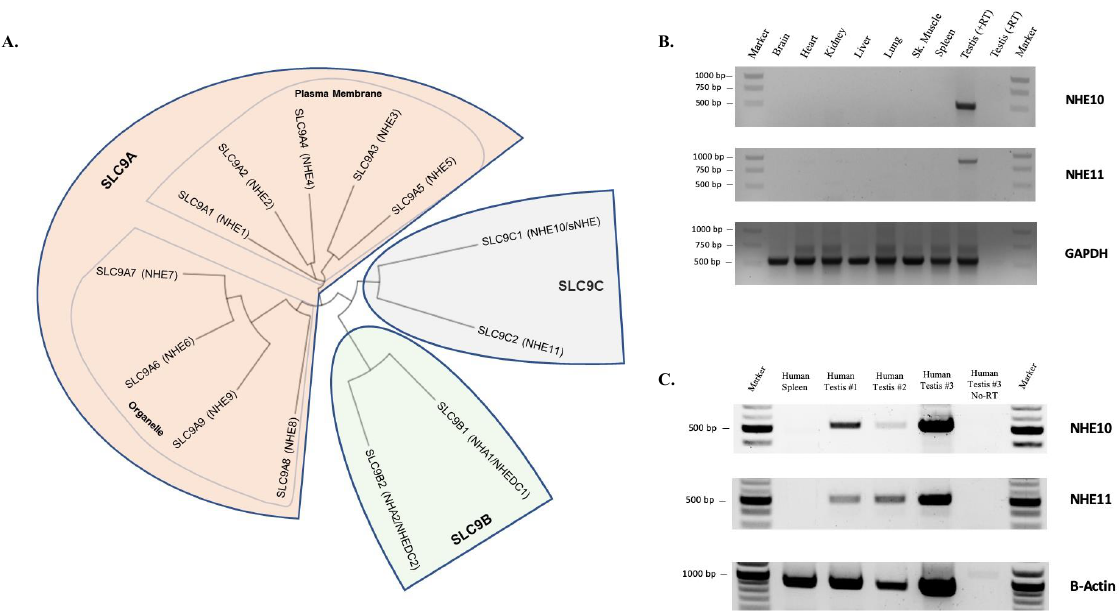
Figure 1. SLC9 gene family and SLC9C2 gene expression. ( A ) Phylogenetic relationships of human SLC9 proteins were calculated using Clustal Omega (https://www.ebi.ac.uk/Tools/msa/clustalo/ (accessed on 7 October 2022), and the tree was generated using Interactive Tree of Life [23]. ( B ) RT- PCR analysis of multiple rat tissues. Both SLC9C1 (NHE10) and SLC9C2 (NHE11) mRNAs are expressed in rat testes but not in any other tissue tested. ( C ) RT-PCR analysis of one human spleen sample and three different human testis samples. NHE10 and NHE11 expression is detected in all three human testis samples but not in the human spleen